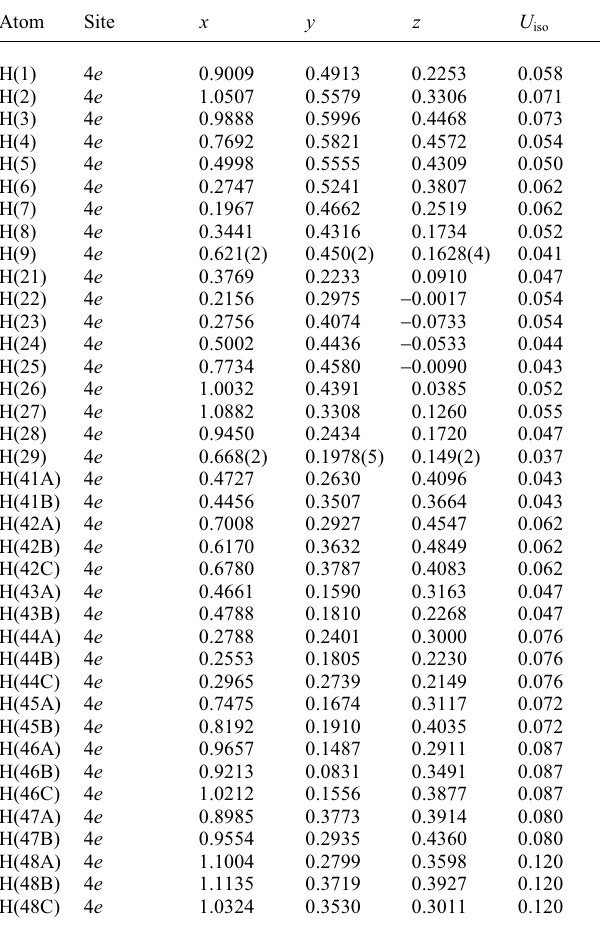
Table 2. Atomic coordinates and displacement parameters (in Å 2 )